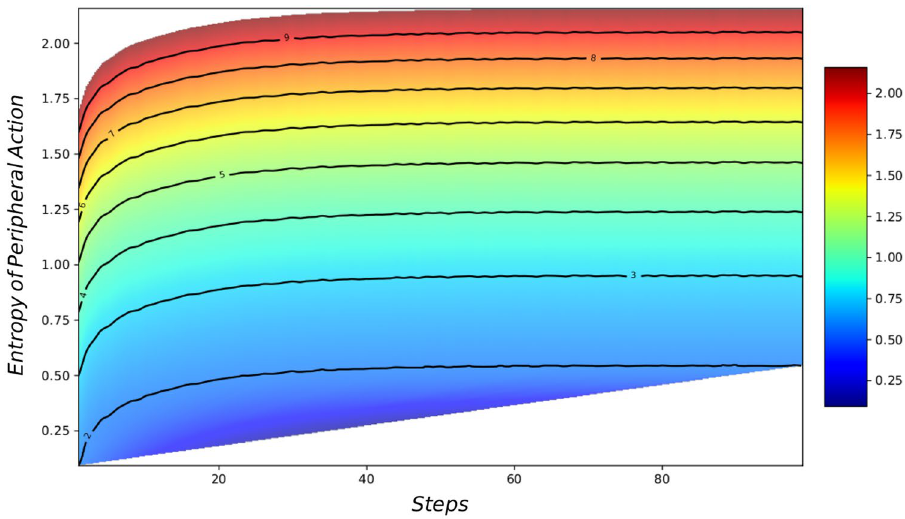
Figure 6. The plot shows the entropies of the peripheral actions ( S peripheral ) of the agents for the different number of total available actions (Dark Blue has n total = 2 actions, Red has n total = 10 actions). It can be seen that the entropy takes higher values as the total amount of the actions of the agents increases. The general trend is that the agents produce more ideological homogeneity over time increasing the uncertainty in the peripheral activities of the